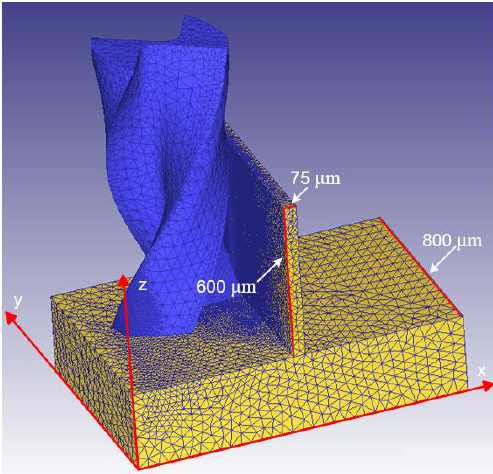
Figure 6. Geometric model of the tool and micro thin-walled structure.